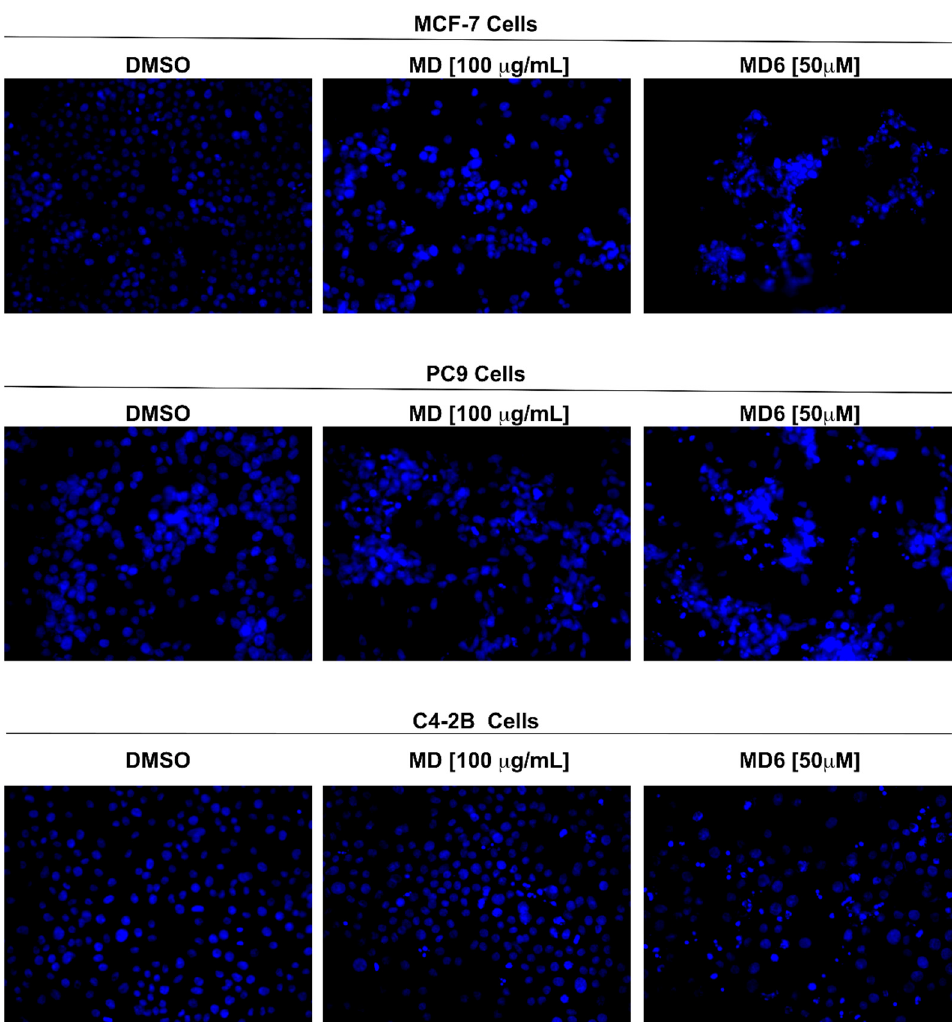
Figure 10. Apoptosis analysis on breast, lung, and prostate cancer cells treated with MD and MD-6 for 24 h. Detection of apoptosis by microscopy using DAPI stain. The microphotographs were acquired with an Olympus IX81 DSU microscope (20× magnification).